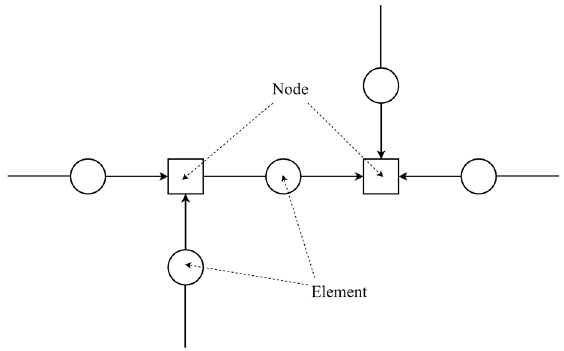
Figure 2. Thermofluid network represented by nodes and elements.